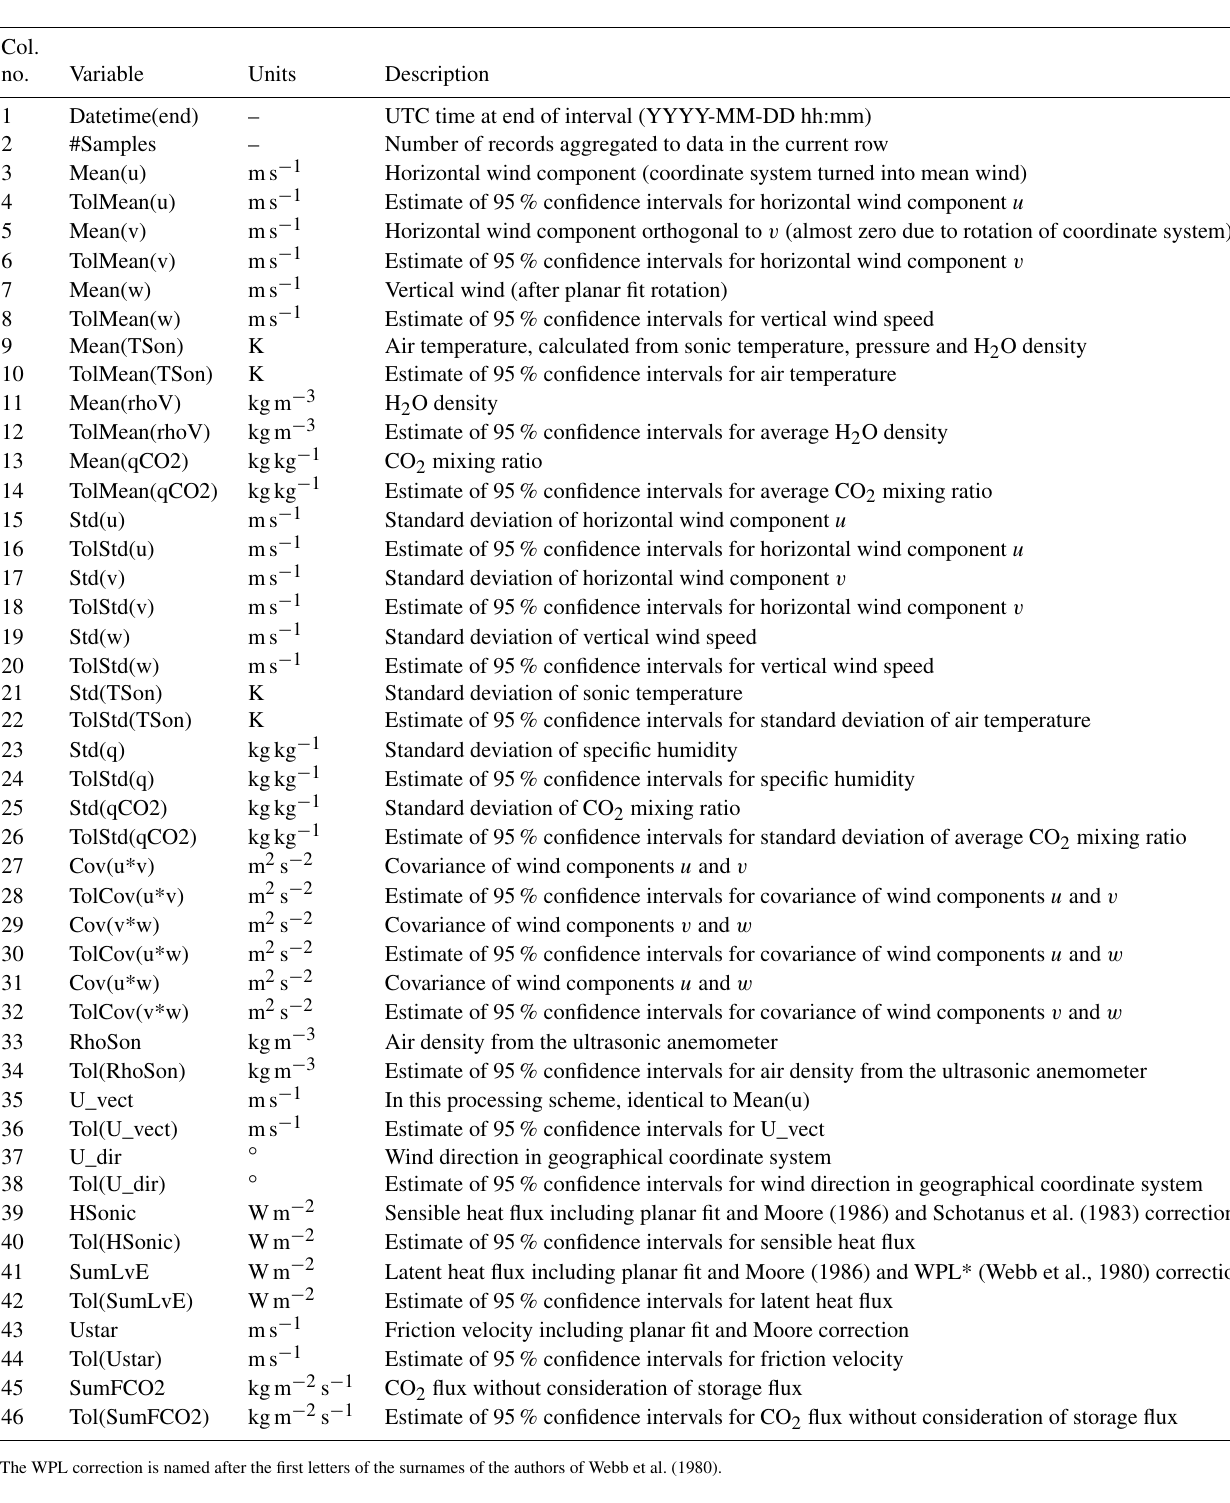
Table A2. Columns of flux data files processed with the software ECpack. With the exception of the timestamps, all data types are numeric.